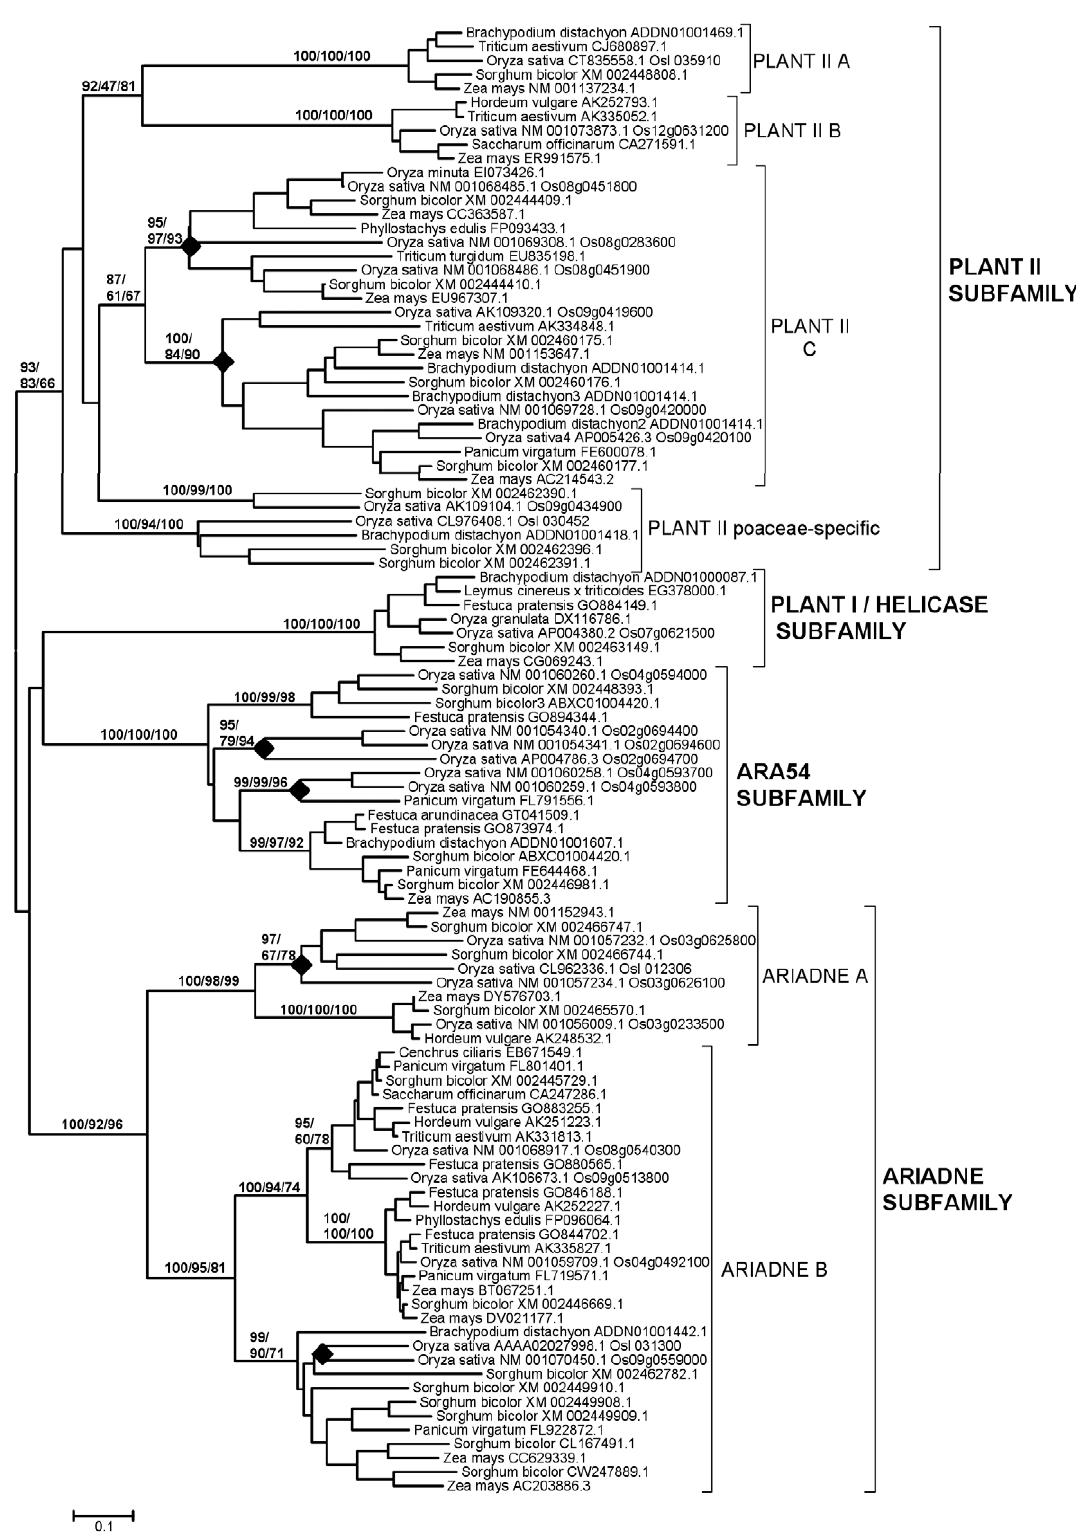
Figure 5. Dendrogram for Poaceae RBRs. Conventions as in Figure 4. Again, rhombs indicate the branches that include tandem duplicates, this time in Oryza sativa .